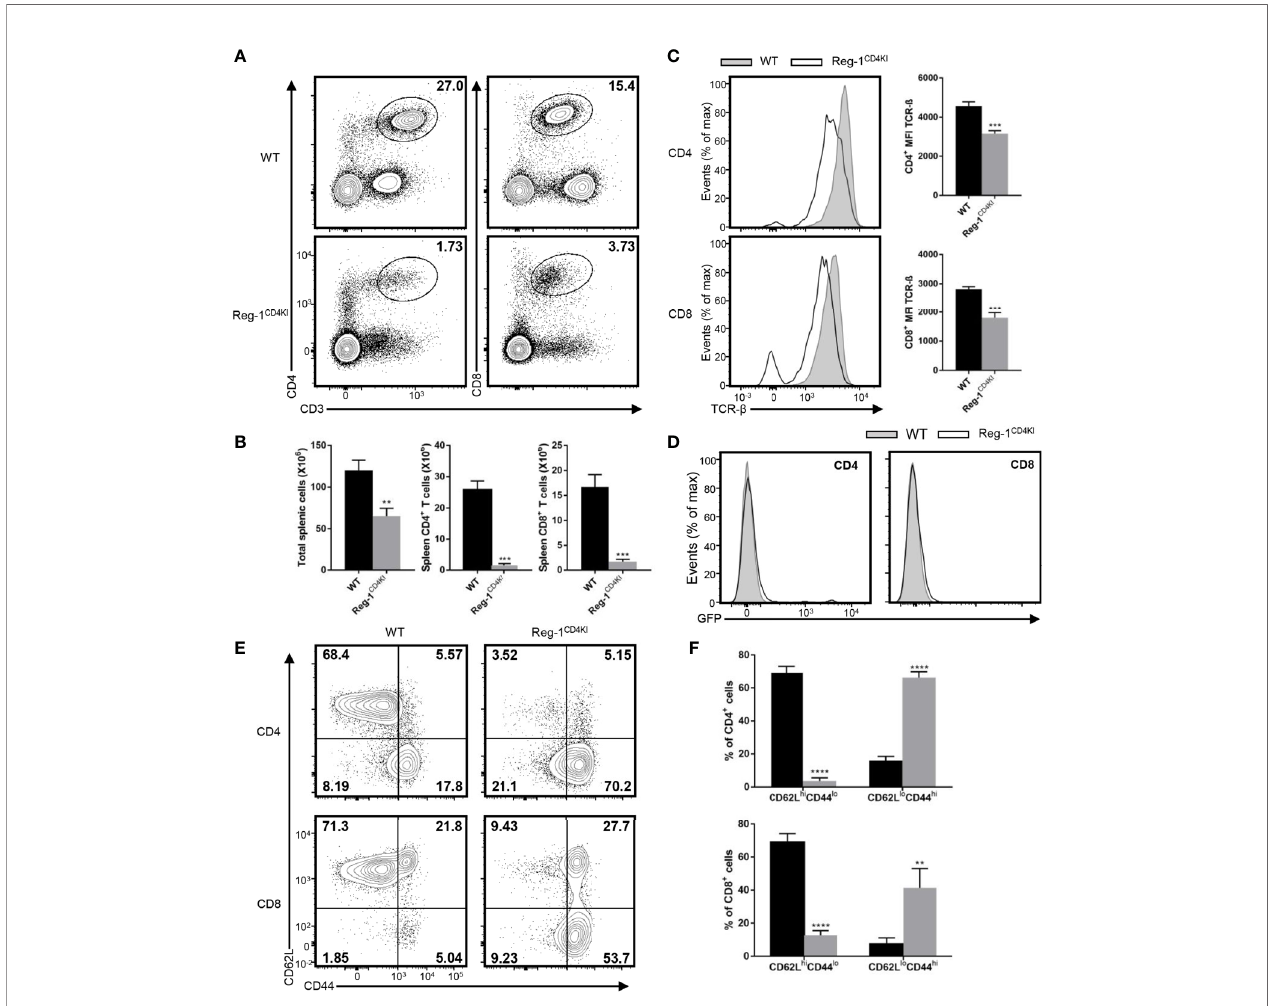
FIGURE 2 | Phenotype of peripheral T cells in Reg-1 CD4KI mice. (A) Surface staining of CD3, CD4 and CD8 on WT or Reg-1 CD4KI splenocytes. The percentage of CD4 + and CD8 + T cell in CD45 + alive splenocytes. (B) The number of total splenocyte, CD4 + and CD8 + splenocytes from WT or Reg-1 CD4KI mice. (C) Flow cytometric analysis and mean fl uorescence intensity of TCR- b on CD4 + or CD8 + splenocytes. (D) The analysis of EGFP expression in spleen cells from Reg-1 CD4KI mice or WT littermates at age of 6-8 weeks. (E) Expression of CD62L and CD44 on CD4 + or CD8 + splenocytes from WT or Reg-1 CD4KI mice. (F) The frequency of CD62L hi CD44 lo and CD62L lo CD44 hi subpopulations in the CD4 + or CD8 + cells. Data are mean ± SD (n=3) from one experiment, representative of two independent experiments. ** P <0.01; *** P <0.001; **** P <0.0001 (unpaired two-tailed Student ’ s t